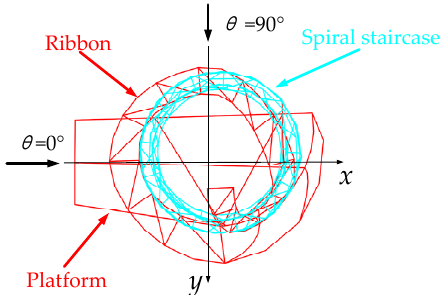
Figure 3. Wind yaw angle definition for wind tunnel test of aeroelastic model.